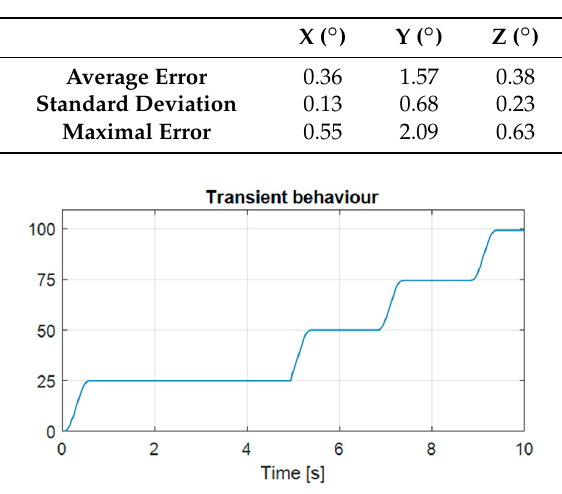
Figure 7. Transient behaviour of the head tracking system for step inputs of 25° each.